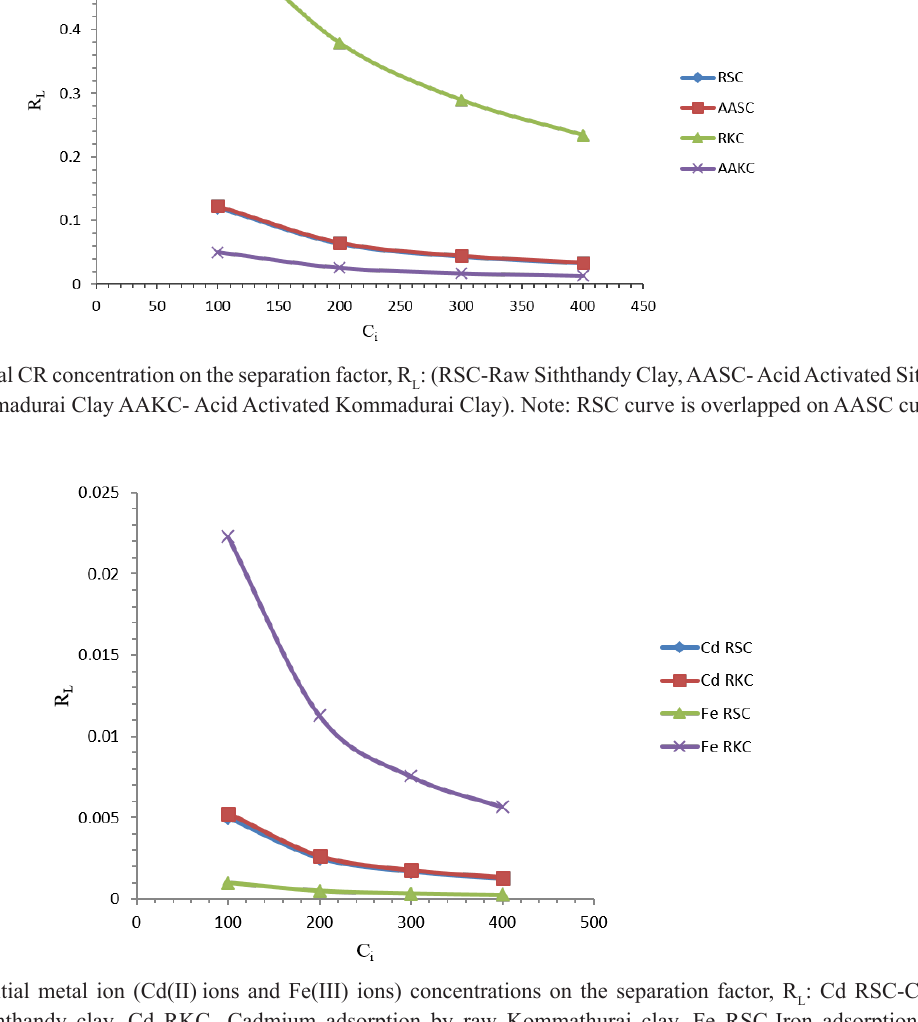
Figure 8: Effect of initial metal ion (Cd(II) ions and Fe(III) ions) concentrations on the separation factor, R adsorption by raw Siththandy clay, Cd RKC -Cadmium adsorption by raw Kommathurai clay, Fe RSC-Iron adsorption by raw Siththandy clay and Fe RKC - Iron adsorption by raw Kommathurai clay. Note: Cd RSC curve is overlapped on Cd